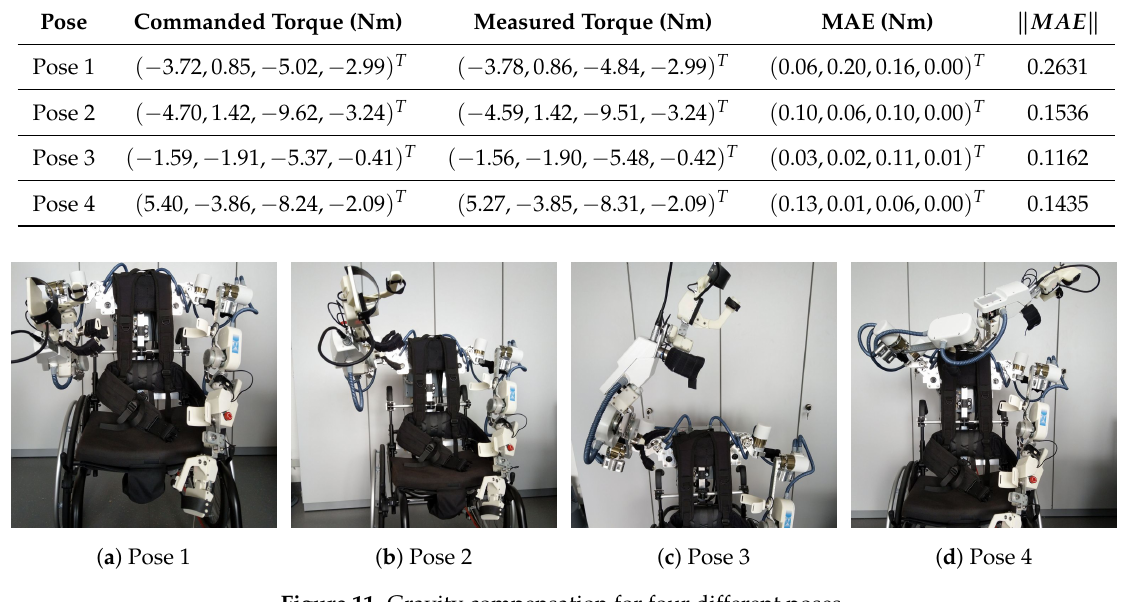
Figure 11. Gravity compensation for four different